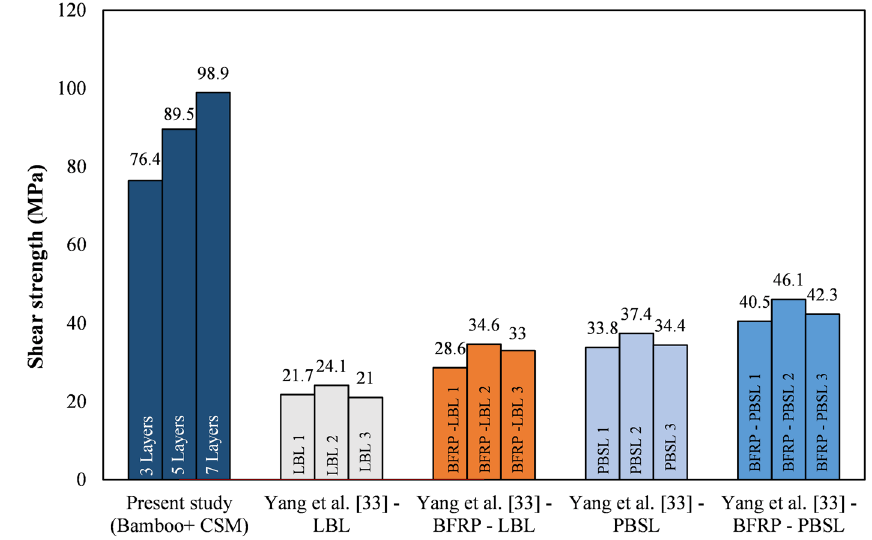
Figure 11: V - notched beam test results under di ff erent numbers of